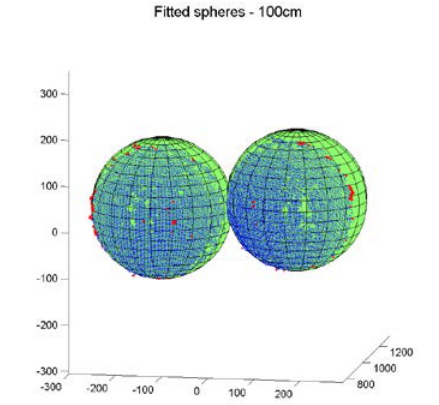
Figure 8. Fitted spheres (red points with residuals over 5 mm). During the sphere fitting, the radius, center point and the fitting residuals were calculated. Obviously, the estimated radius should be comparable with the directly measured one, and similarly, the center point distances are also computable and should be twice the radius (Figure 9).